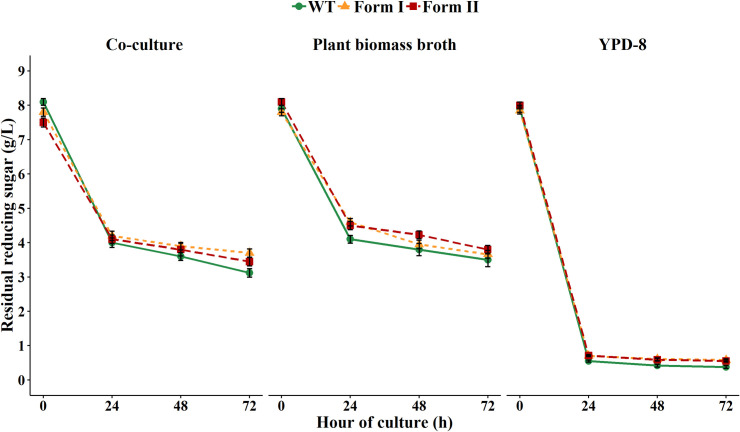
Residual reducing sugar concentration profiles in the fermentation process.The left panel shows the reducing sugars in the co-culture system (H. thermocellum + K. marxianus) in modified GS-2 medium supplemented with 100g/L Napier grass. The middle panel shows the residual reducing sugars in the Napier grass broth. The right panel shows the residual glucose in YPD-8 medium.